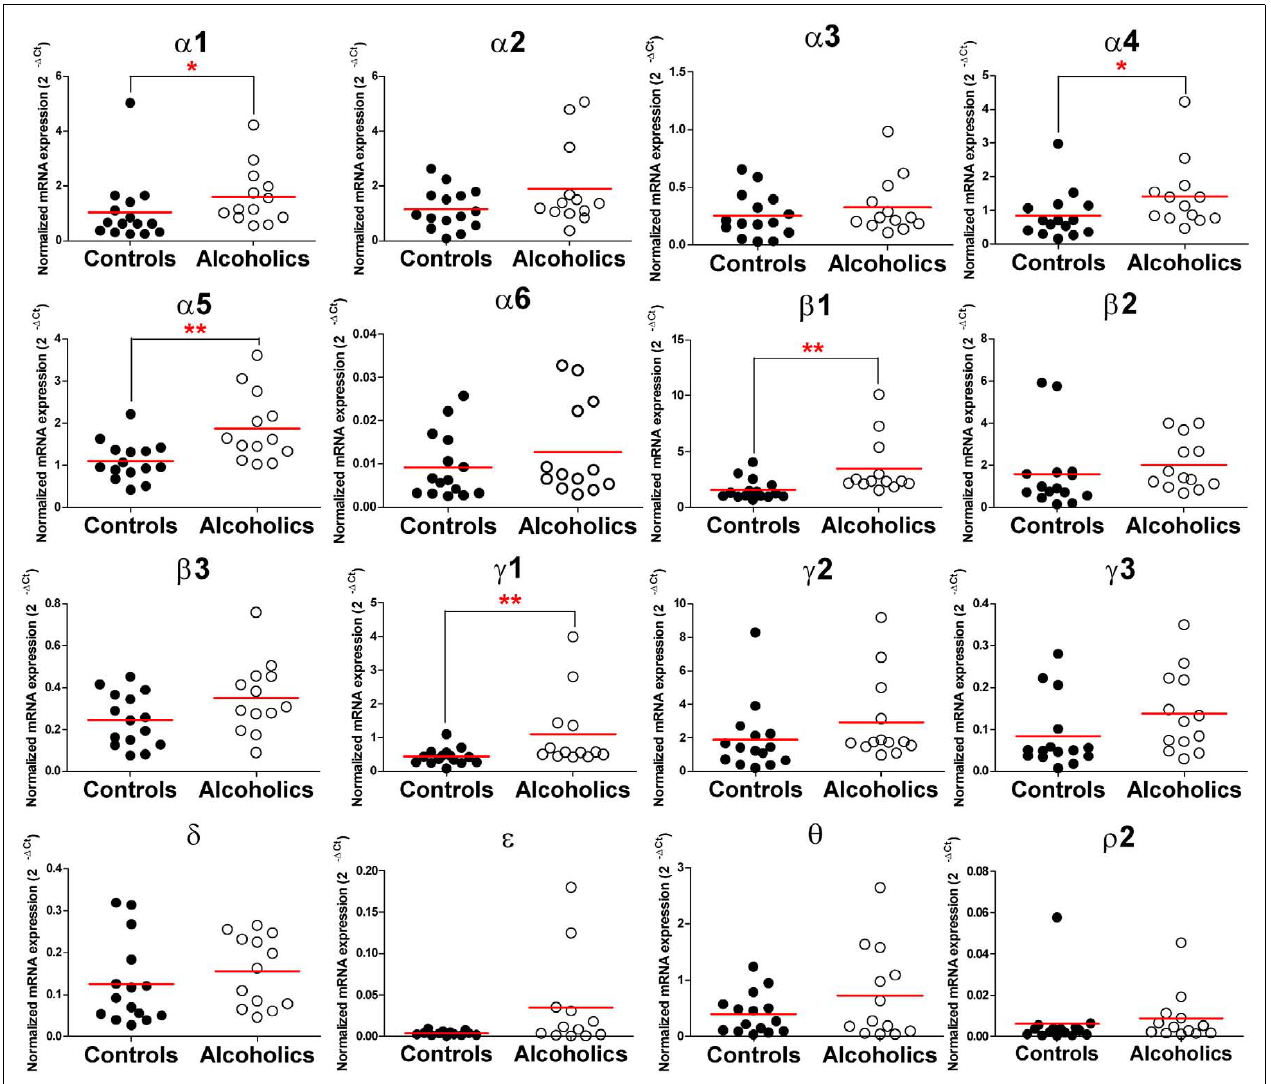
α 6, H (1, 28) = 1.17, p = 0.28; β 1, H (1, 28) = 9.38, p = 0.002; β 2, H (1, 28) = 2.68, p = 0.10; γ 1, H (1, 28) = 7.02, p = 0.008; γ 2, H (1, 28) = 2.83, p = 0.09; γ 3, H (1, 28) = 3.31, p = 0.07; δ , H (1, 28) = 1.07, p = 0.3; ρ 2, H (1, 28) = 1.97, p = 0.16; θ , H (1, 28) = 0.38, p = 0.53; ε , H (1, 28) = 2.32, p = 0.13. One way ANOVA with Bonferroni post hoc test, β 3, df = 23, p =